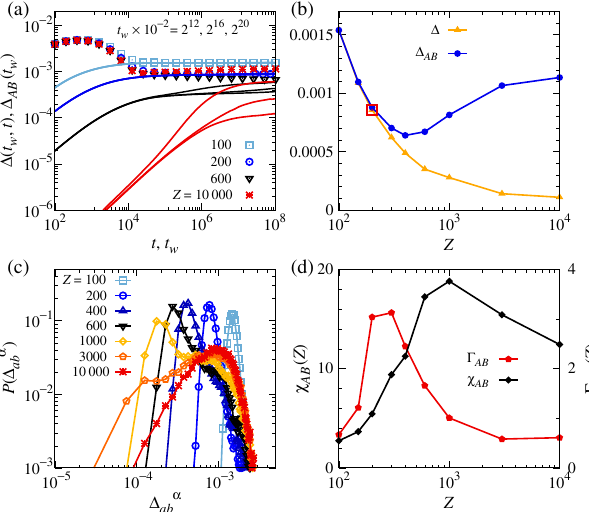
FIG. 3. Signatures of an (avoided) Gardner transition in 2 d hard disks following the dynamics after a quench. (a) Time evolution ð t Þ (symbols) for different pressures. ; t Þ (line) and Δ of Δ ð t w AB w ≈ 200 , Δ ð t ; t Þ exhibits aging and is smaller than For Z > Z G w Δ ð t Þ at long times. (b) The plateau values Δ ð t → ∞ ; t → ∞ Þ AB w w ð t → ∞ Þ start to differ for Z > Z and Δ . (c) The probability AB w G distributions of distances between clones at various pressures for ¼ 10 8 become non-Gaussian for Z > Z t . (d) The skewness w G ð Z Þ and susceptibility χ ð Z Þ measured at t ¼ 10 8 both Γ AB AB w exhibit a peak at a finite